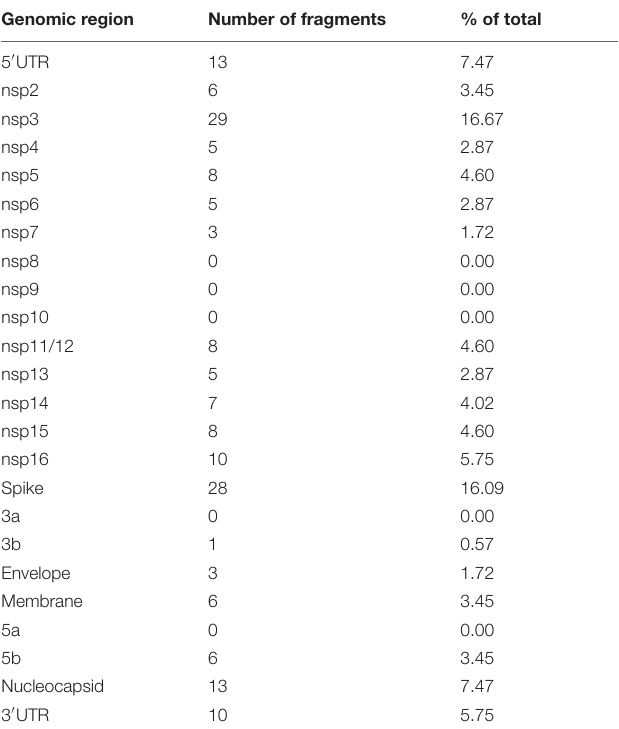
TABLE 1 | Number of transferred fragments associated with individual areas of the genome for all of the isolates in